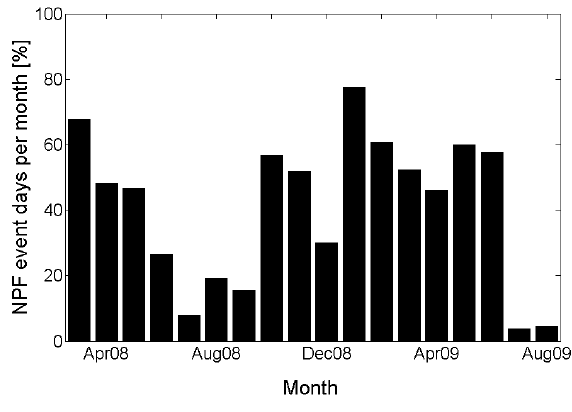
Fig. 7. Frequency of NPF event days in each Figure 7. Frequency of NPF event days in each month. 3